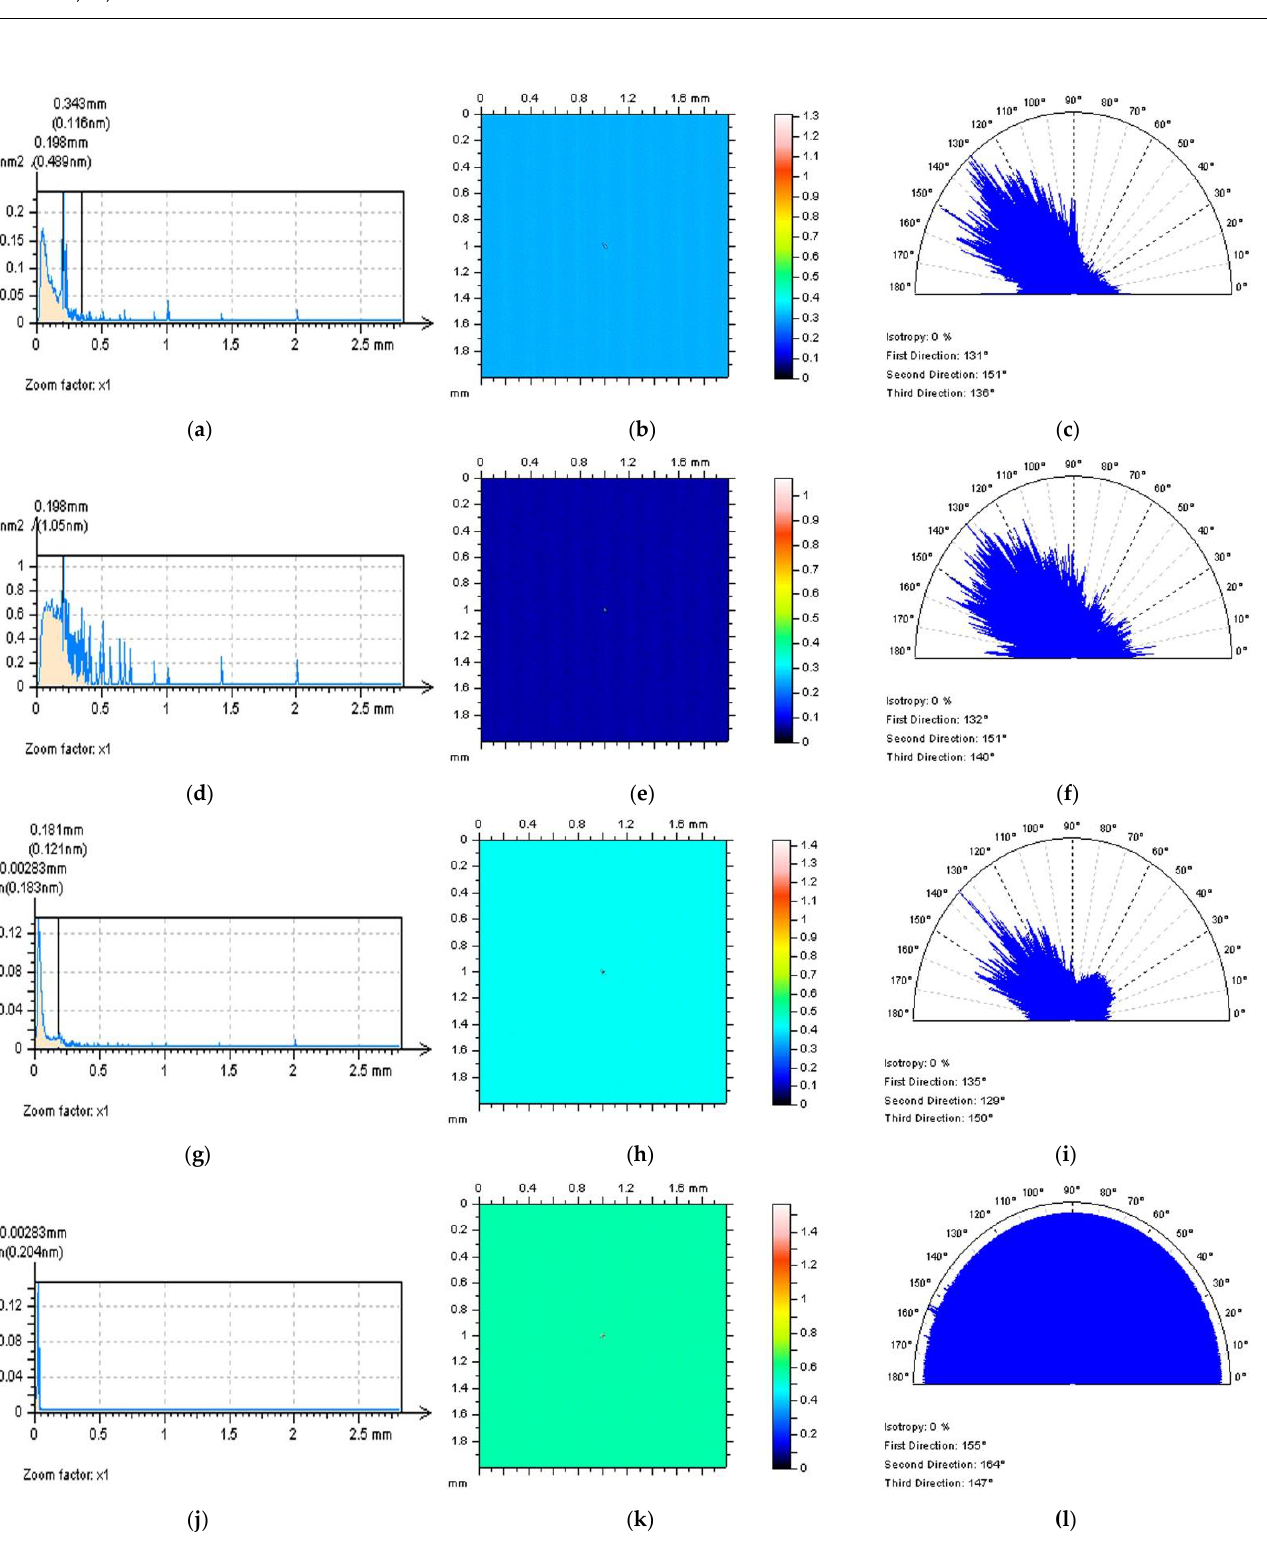
Figure 3. PSDs (left column), ACFs (middle), and TDs (right column) of NSs received from the turned surface topography after application of GF ( a – c ), RGF ( d – f ), SF ( g – i ), and FFTF ( j – l ). Cut-off = 0.015 mm.